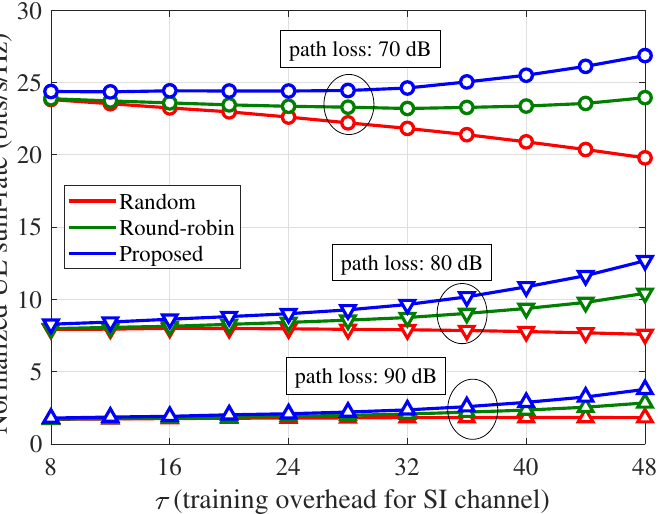
Figure 8. Normalized UL sum-rate ( η u ) per channel use according to the path loss between the BS and UE and SI training overhead ( τ ): K u = 8, α = 70 dB, and κ ij = 3.